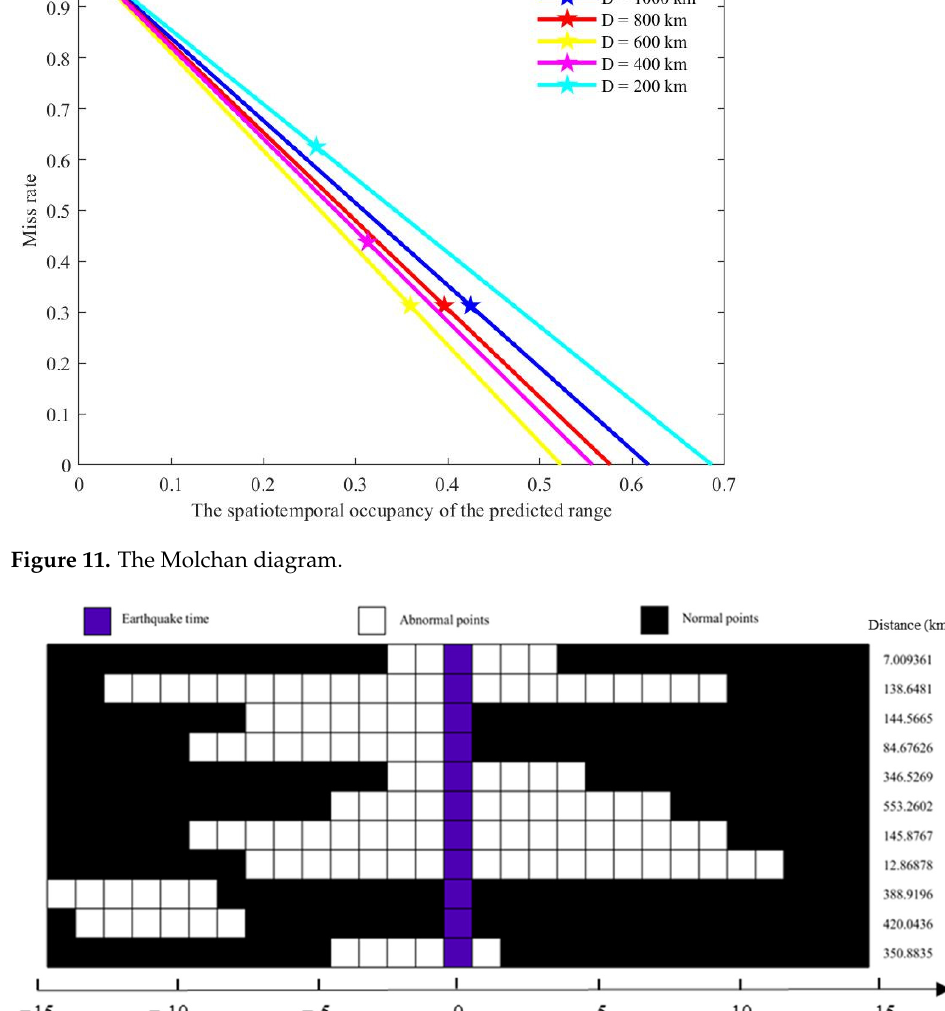
Table 7. The considered earthquakes with a pre-seismic anomaly.